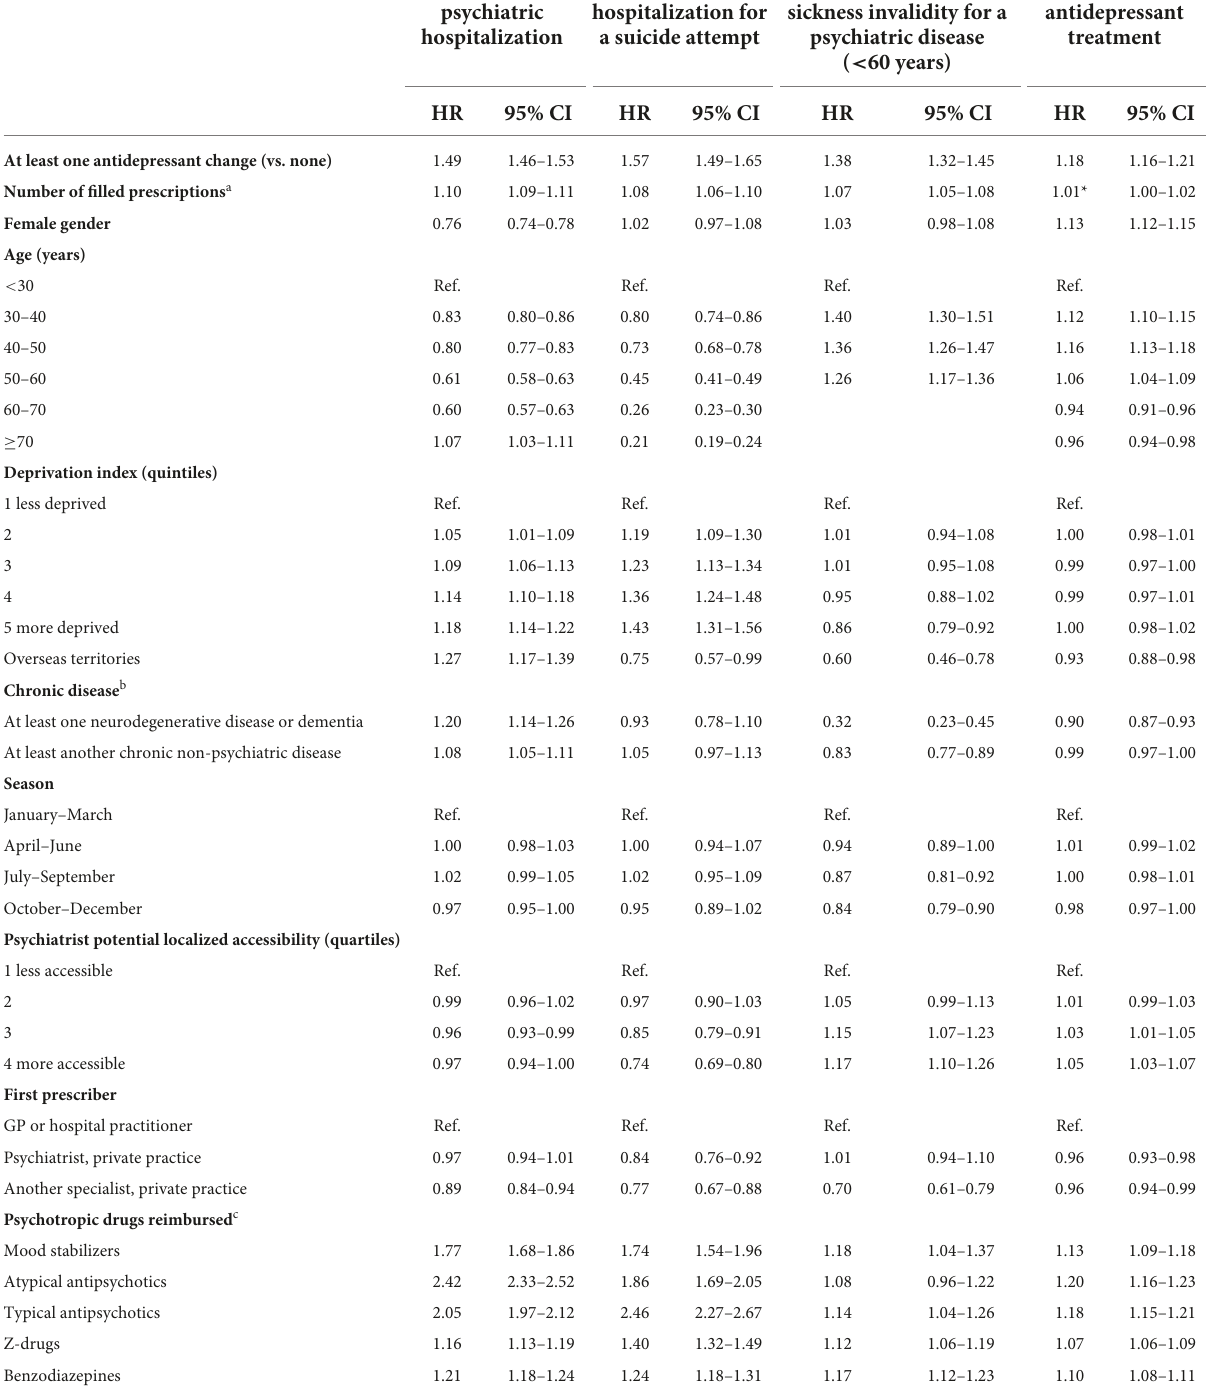
TABLE 4 Hazard ratios for each long-term psychiatric outcome according to the occurrence of at least one antidepressant change and the number of filled prescriptions among patients with a least two filled